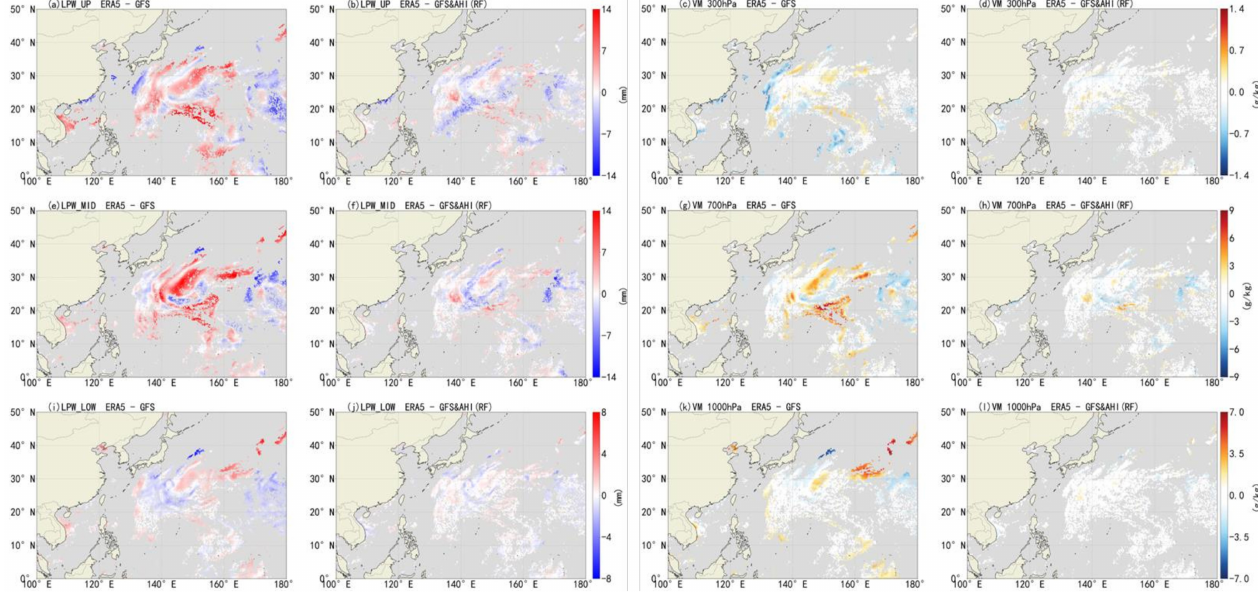
Figure 4. Differences between the ERA5 and the retrievals/GFS of LPWs for ( a , b ) upper, ( e , f ) middle and ( i , j ) low layers, the retrievals/GFS of VM at ( c , d ) 300 hPa, ( g , h ) 700 hPa and ( k , l ) 1000 hPa, respectively. The retrievals are from the RF-based